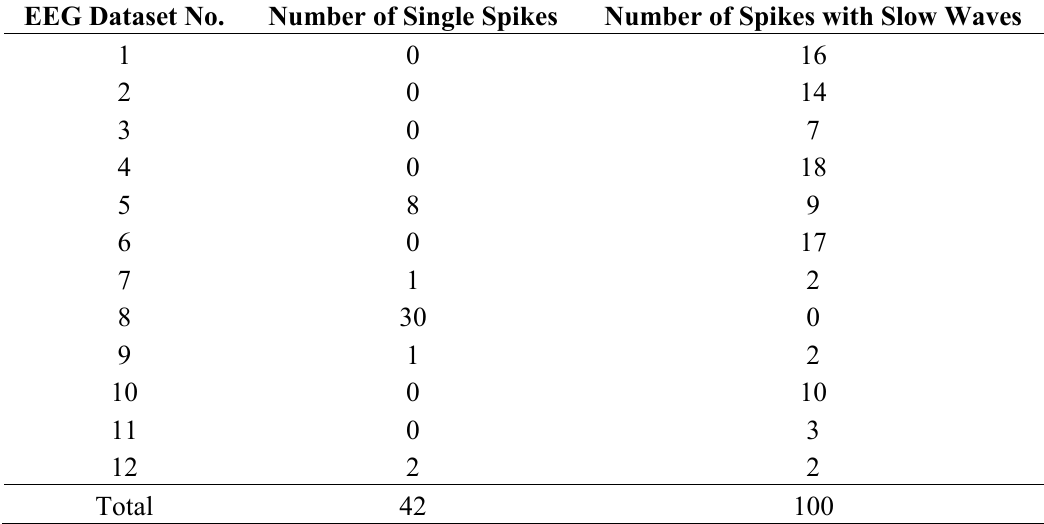
Table 1. The numbers of single spikes and spikes with slow waves for each EEG dataset. EEG Dataset